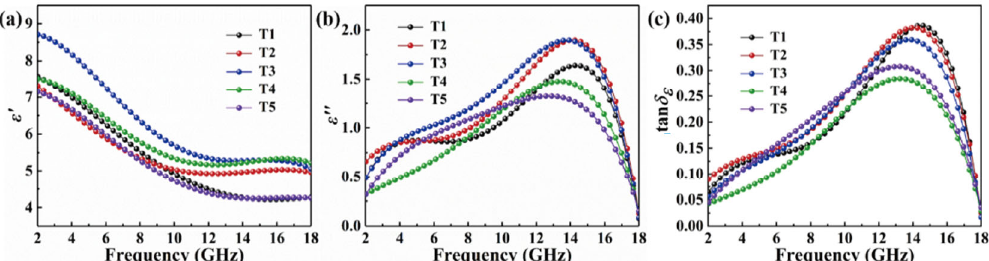
Fig. 5 (a) ε ′ and (b) ε ″ of the complex permittivity, (c) dielectric tangent loss (tan δ ε ) of MoO 3 /TiO 2 /Mo 2 TiC 2 T x composites at various annealing